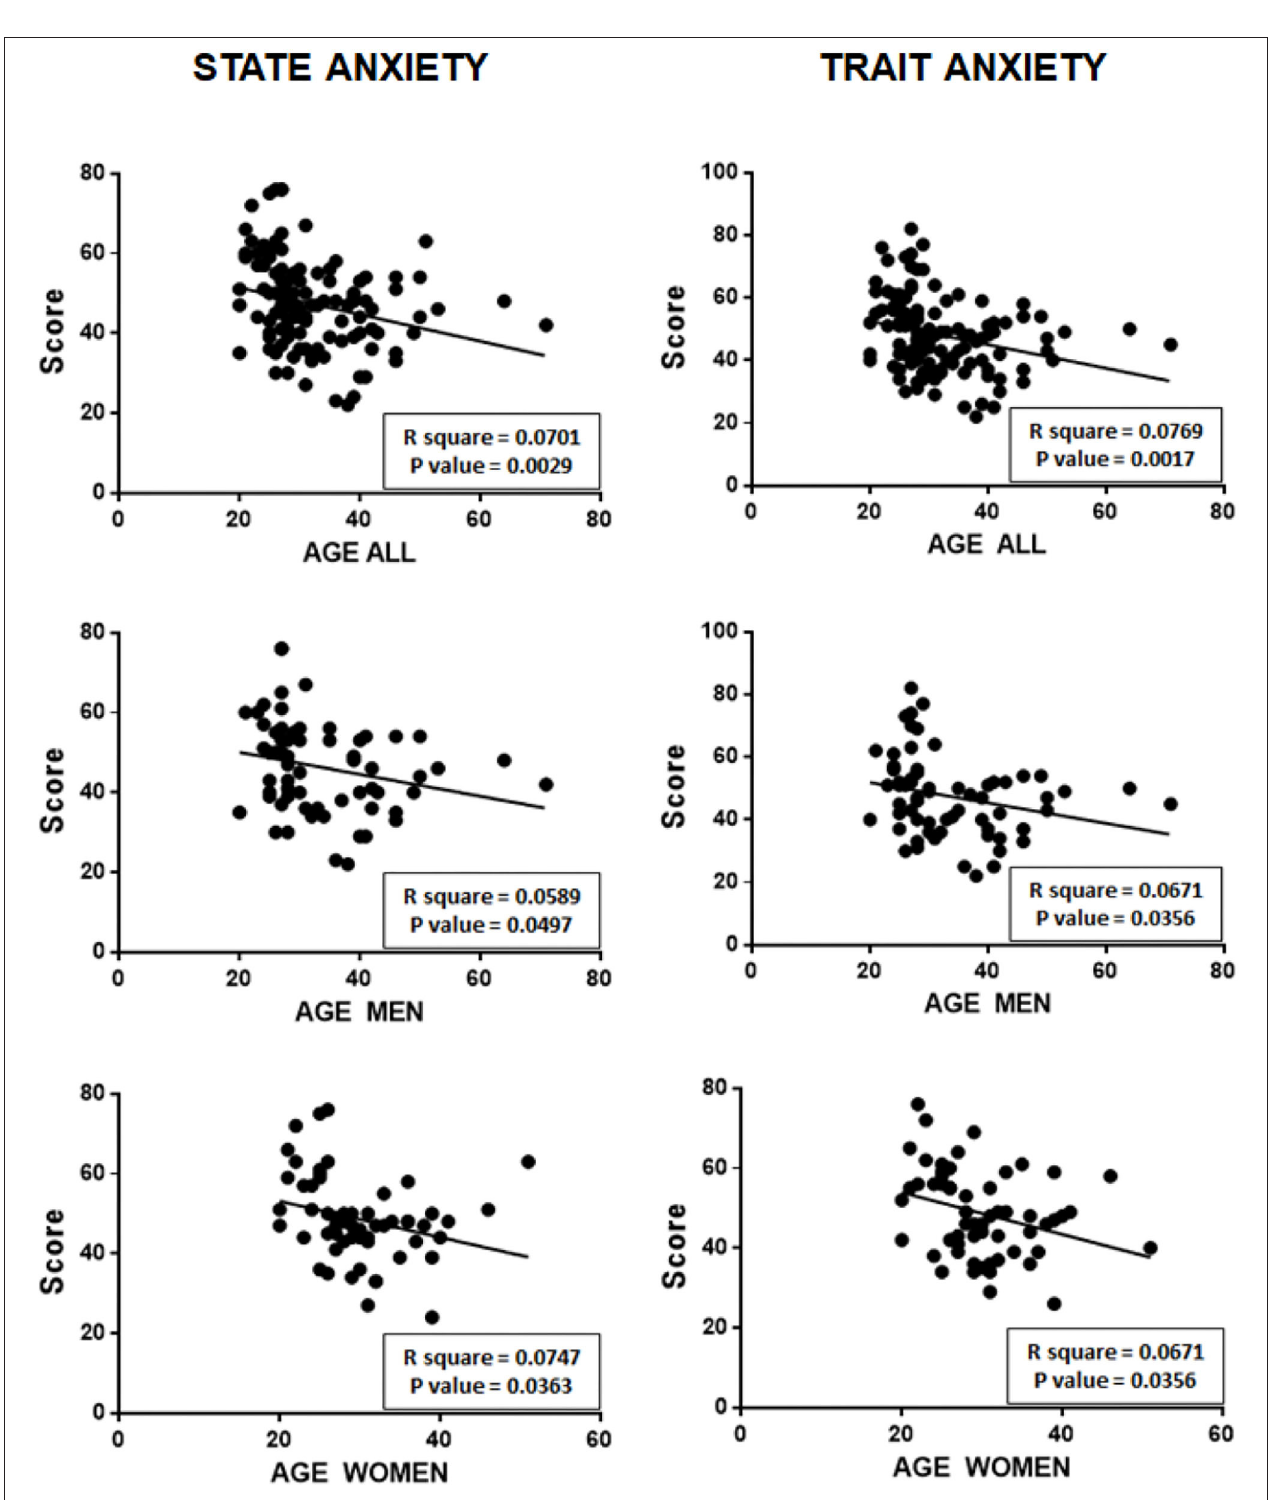
FIGURE 4 | Negative correlations between the ages of participants and state and trait anxiety scores, both of the total sample, and separately for men and women.